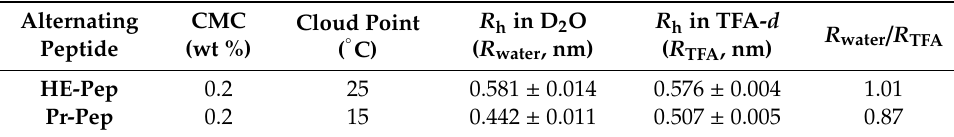
Table 1. CMC, cloud point, and hydrodynamic radius ( R h ) of HE-Pep and Pr-Pep a .